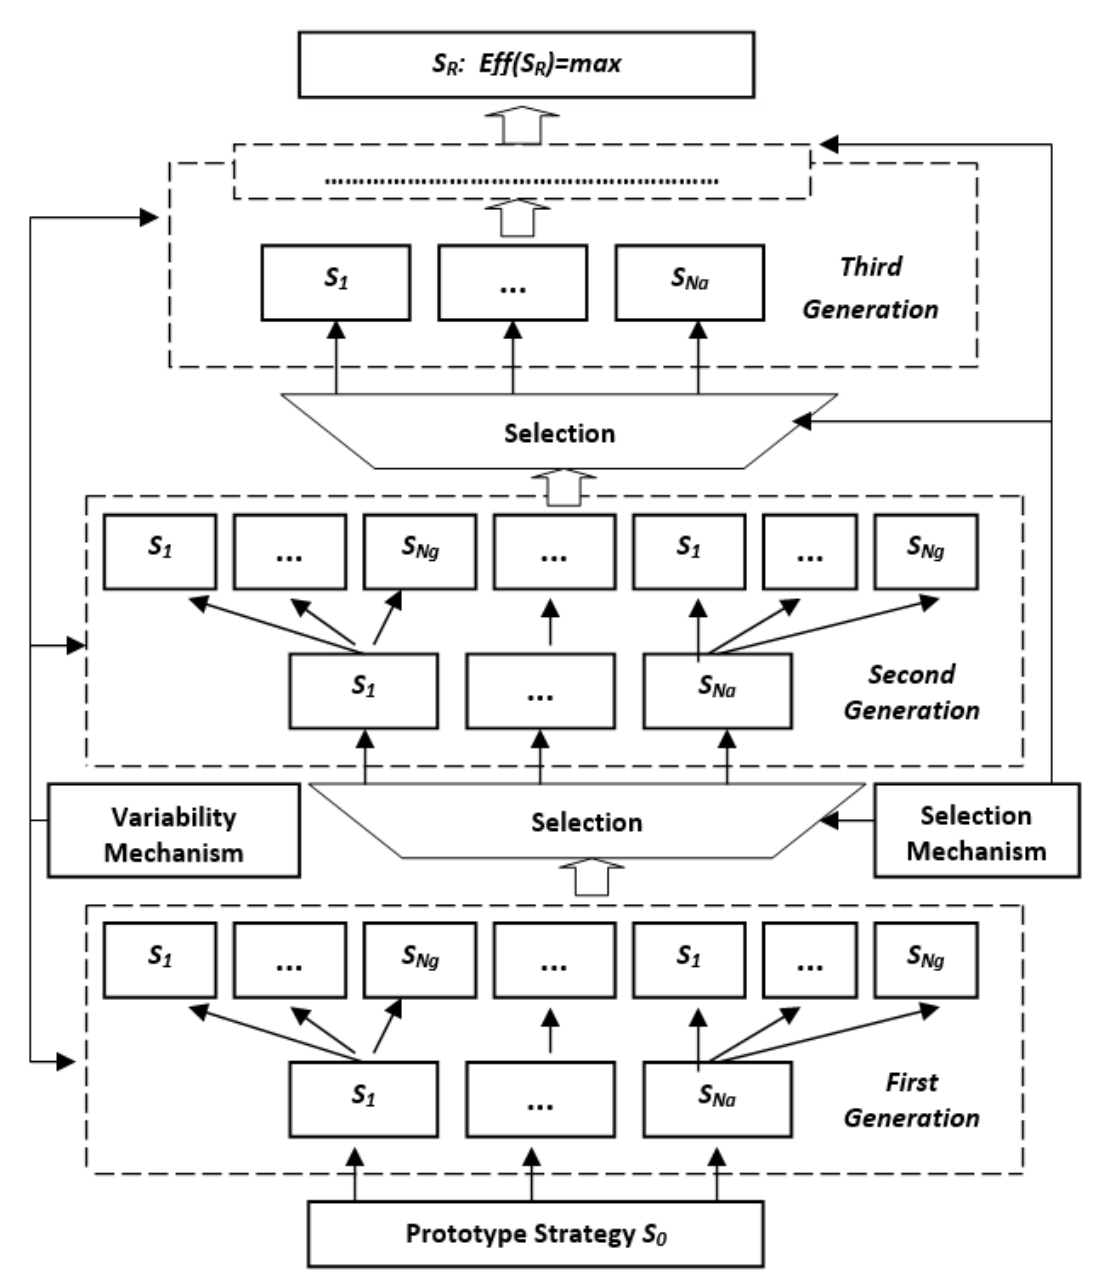
Figure 7. General functional structure of the evolutionary optimization algorithm.